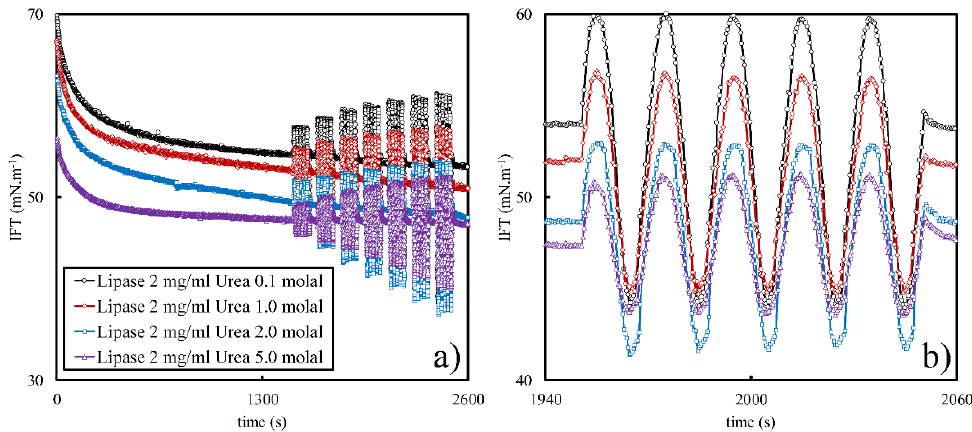
Figure 2. ( a ) Effect of urea on the dynamic interfacial tensions of the adsorbed layers from lipase 2 mg · mL − 1 solutions with urea concentrations of 0.1, 1.0, 2.0, and 5.0 molal while imposing area oscillations of different amplitudes; ( b ) zoomed-in view on one oscillation from ( a ) with the frequency of 0.05 Hz and the amplitude of 21% between 1950 and 2050 s; the solid lines are drawn as a guide for the